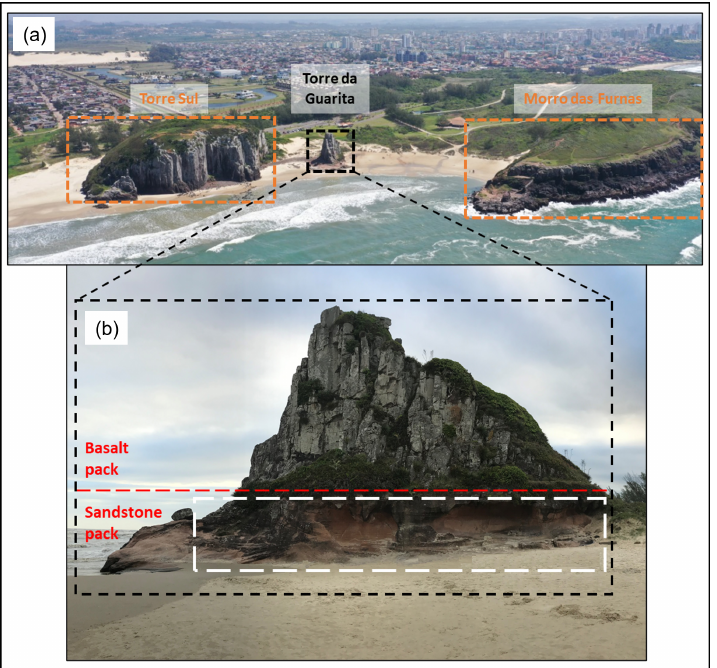
Figure 2. Outcrops of Parque Estadual da Guarita site, showing the three discontinuous structures ( a ) and the region captured with the omnidirectional camera ( b